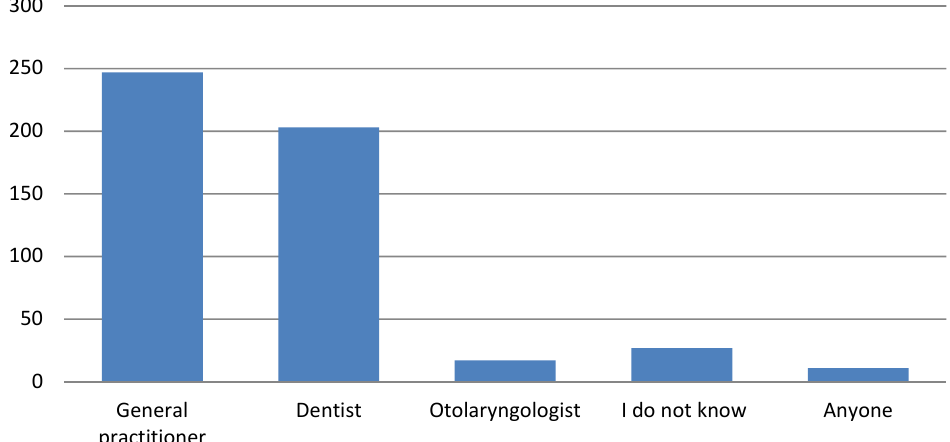
Figure 7. Answers to questions about professional reference figures.